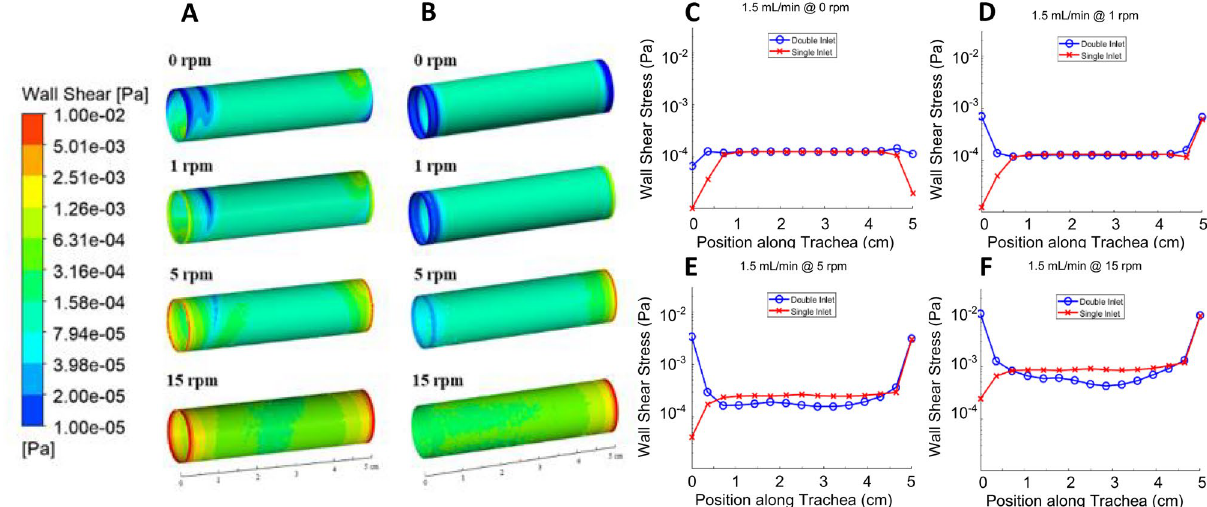
Figure 2. Luminal wall shear stress within the bioreactor. Wall shear stress contours with the ( A ) double (blue) and ( B ) single (red) inlet designs at different tracheal rotational speeds; comparison plots of the lumen wall shear stress at 1.5 mL/min at ( C ) 0 rpm, ( D ) 1 rpm, ( E ) 5 rpm, and ( F ) 15 rpm. (A) and ( B ) were generated using ANSYS Workbench v19.1 (ANSYS Inc., Cannonsburgh, PA, USA; https ://www.ansys .com). ( B ), ( C ) and ( D ) were generated using MATLAB 2018b (Mathworks Inc., Natick, Massachusetts, USA; https ://www.mathw